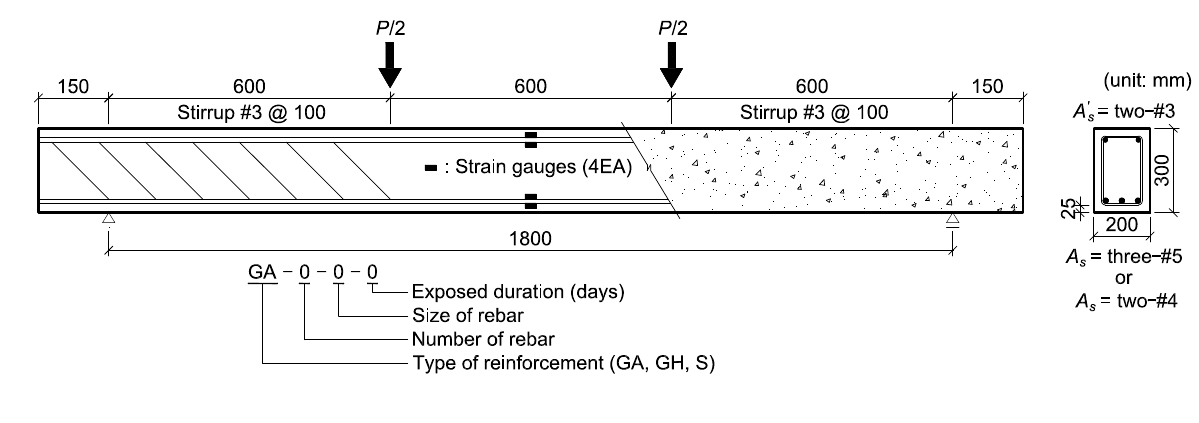
Figure 4. Test set-up and details of a